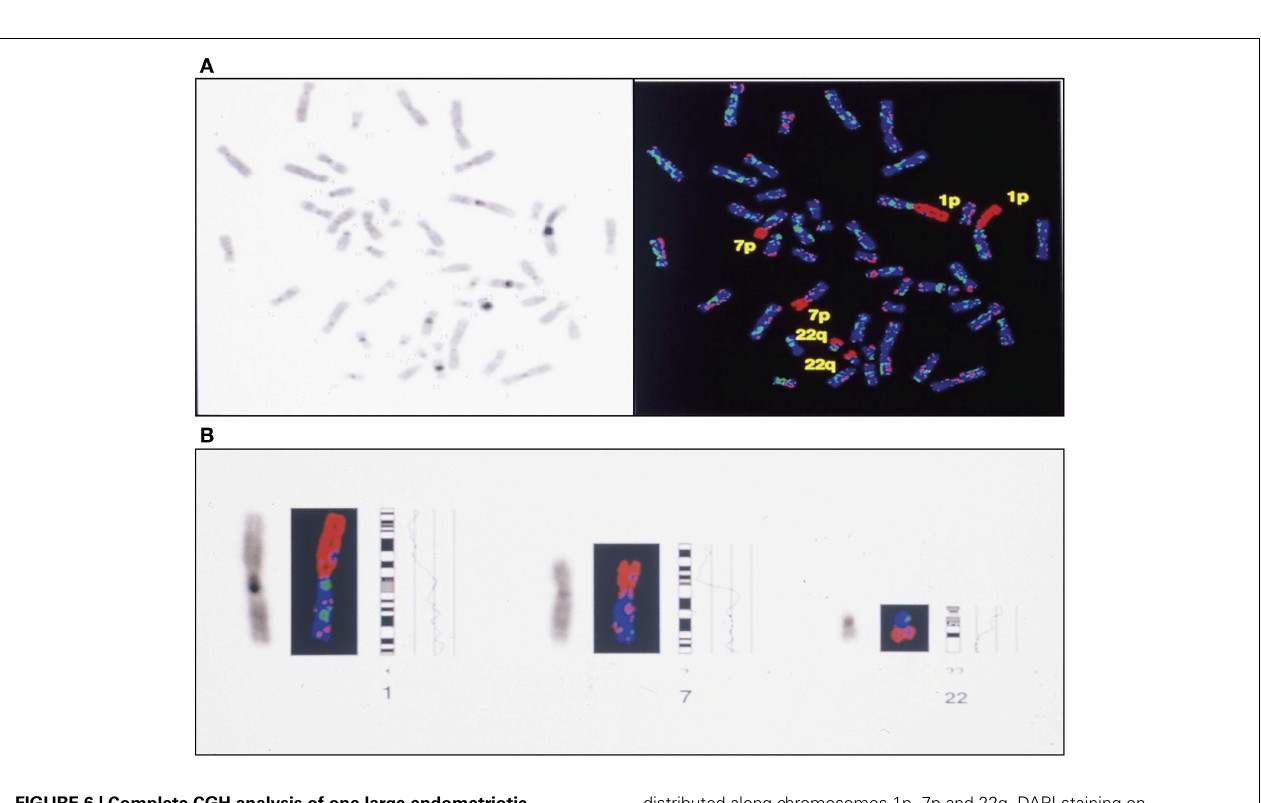
FIGURE 6 | Complete CGH analysis of one large endometriotic peritoneal implant presented in (A) . Compilation of fluorescence ratio profiles from 10 different metaphases was used to calculate the average ratio profiles of this sample. As shown, copy number losses are